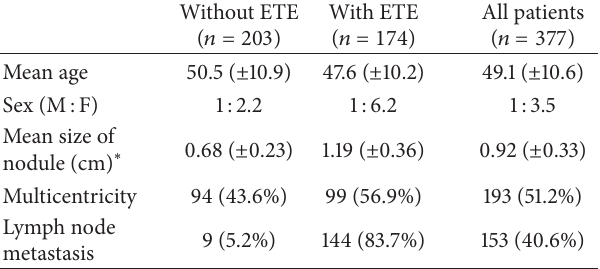
Table 1: Demographics and characteristics of